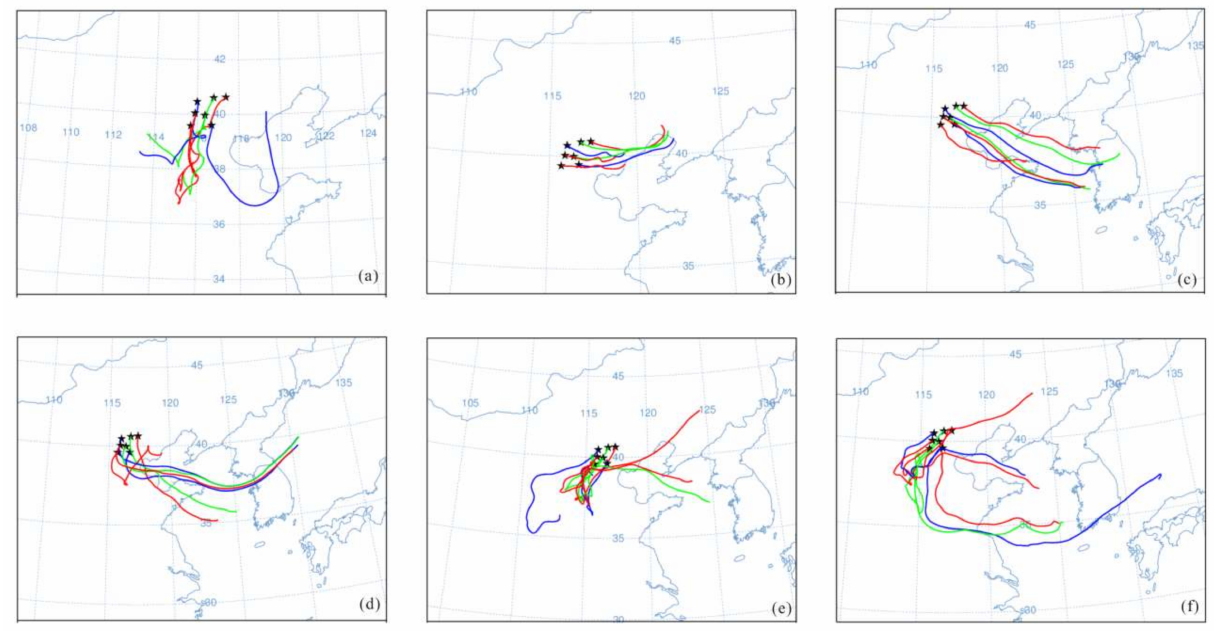
Figure 8. Moisture trajectories obtained using the HYSPLIT model through the layer from the surface to 1500 m for 48 h at 08:00 Beijing Time on ( a ) 15 July, ( b ) 16 July, ( c ) 17 July, ( d ) 18 July, ( e ) 19 July, and ( f ) 20